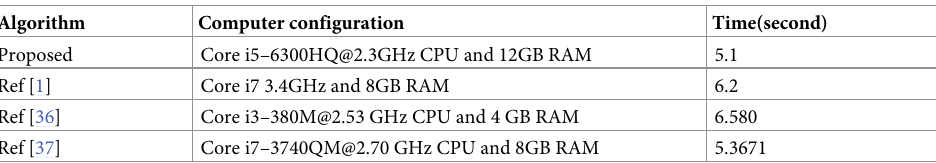
Table 11. Time consumption of encryption